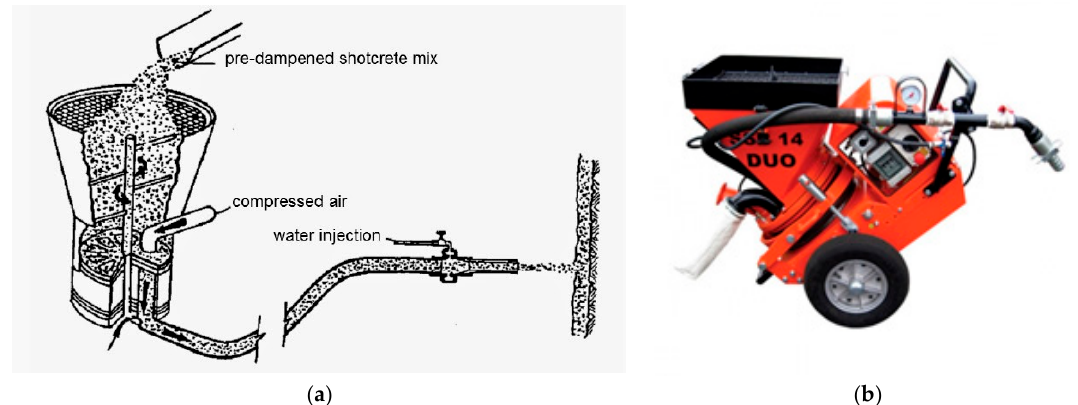
Figure 6. ( a ) Scheme of the dry mix spraying machine and ( b ) the SSB 14 DUO spraying machine